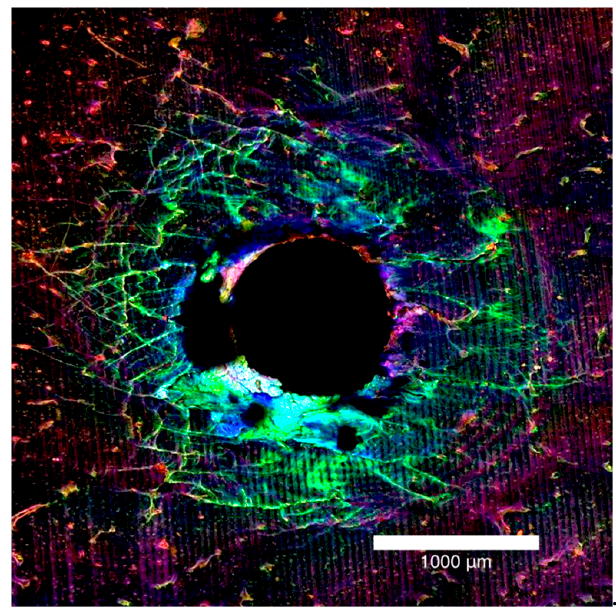
Figure 2. Laser confocal microscope images presented in Figure 1, stacked together to form a composite view of the entry surface of a 2.0 mm bone block specimen.